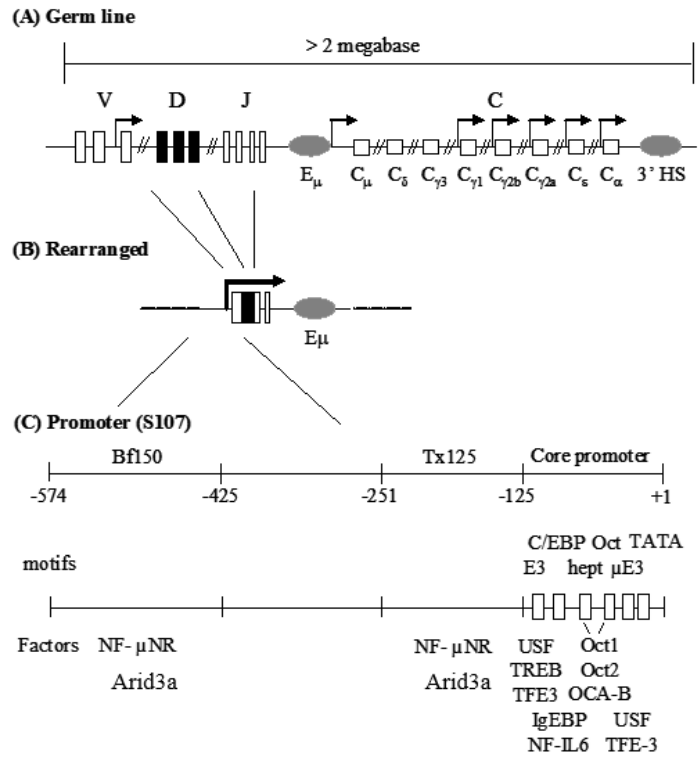
Figure 1. Mouse IgH locus and the S107 V H 1 promoter region. ( A ) IgH gene locus consists of gene segment clusters in the germ line. Boxes indicate exons and gray ovals are enhancers. Arrows indicate germ-line transcription; ( B ) Gene rearrangement assembles a functional VDJ exon and juxtaposes the V H -associated promoter with the intronic enhancer, E µ ; ( C ) The promoter of the V H 1 variable gene of the S107 family is composed of a core promoter and two MARs. Closed triangles and open boxes represent cis protein binding sites within MARs or core promoter, respectively. Transcription factors are shown under the motifs to which they bind.